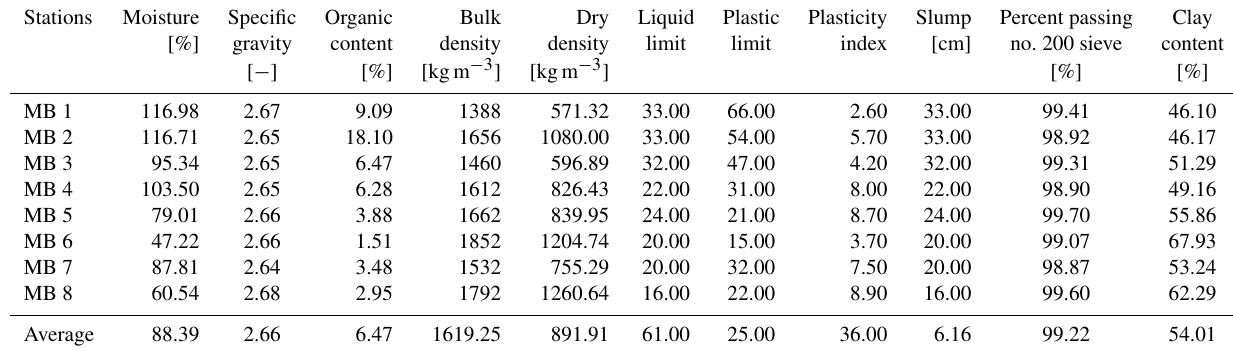
Table 3. Summary of the sediment characteristics measured at every data collection frame along the main transect.